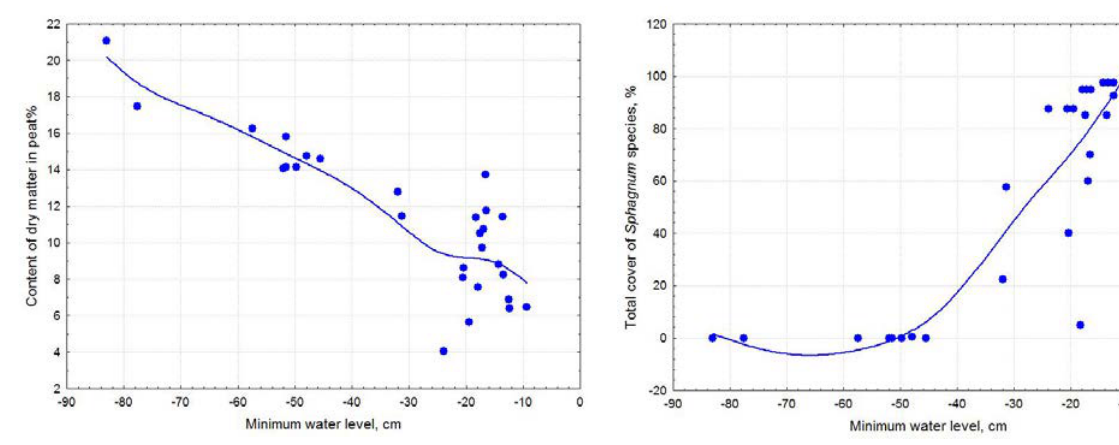
Figure 4. Relationship between the dry matter content of peat and minimum water level.